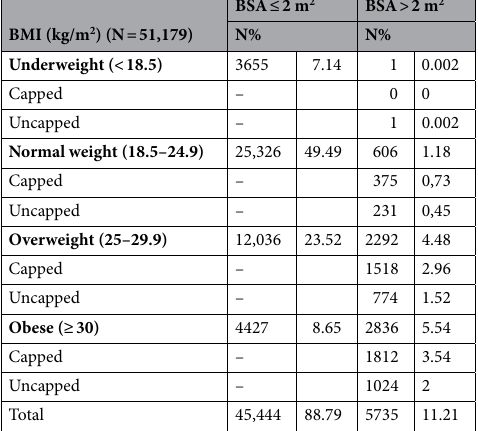
Table 4. Distribution of prescriptions according to IMC, and body surface (SC ≤ 2 m 2 and SC > 2 m 2 ).